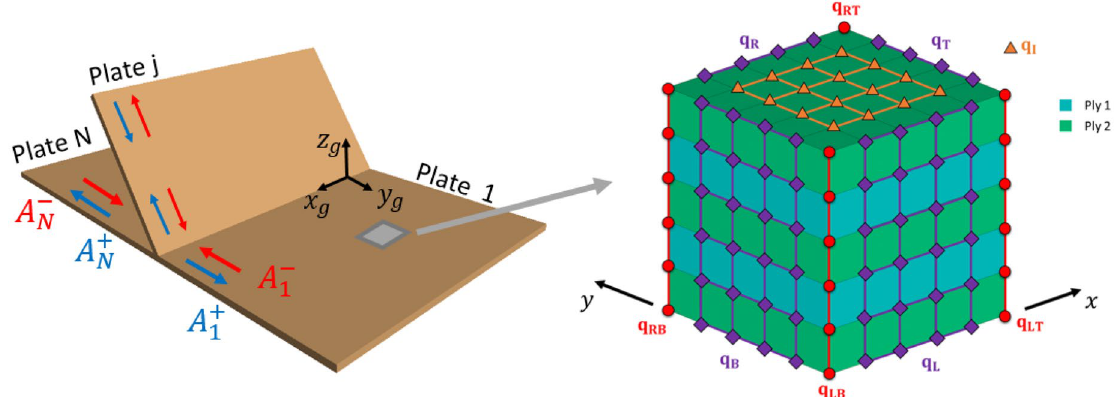
Figure 1. The set up of N plates joined together and a periodic segment of a plate with two different alternating plies modelled with three-dimensional finite elements. A ± 1, N are the amplitudes of incoming and outgoing waves travelling from infinity towards the junction and from the junction to infinity, respectively. The degrees of freedom are grouped into internal q I , edge q L , q R , q B , q T and corner q LB , q RB , q LT , q RT degrees of